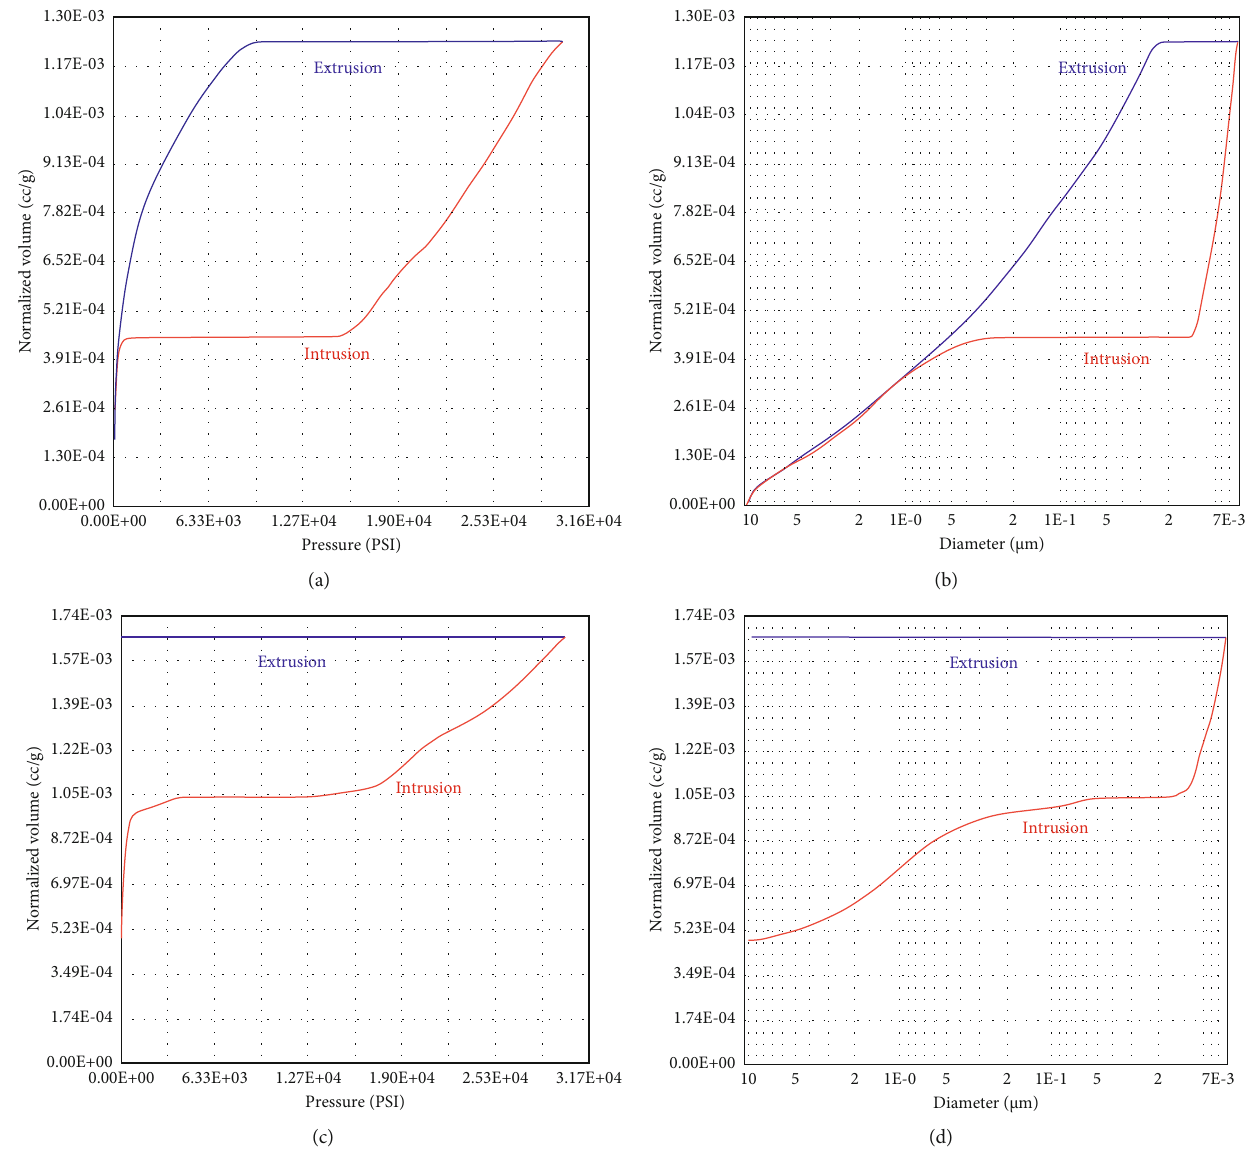
Figure 8: The intrusion and extrusion of Hg curves of the Shanxi Formation and Taiyuan Formation by MICP analysis. (a, b) Show the intrusion-extrusion MICP curves of volume with pressure and pore diameter for the Shanxi Formation. (c, d) Show the intrusion- extrusion MICP curves of volume with pressure and pore diameter for the Taiyuan